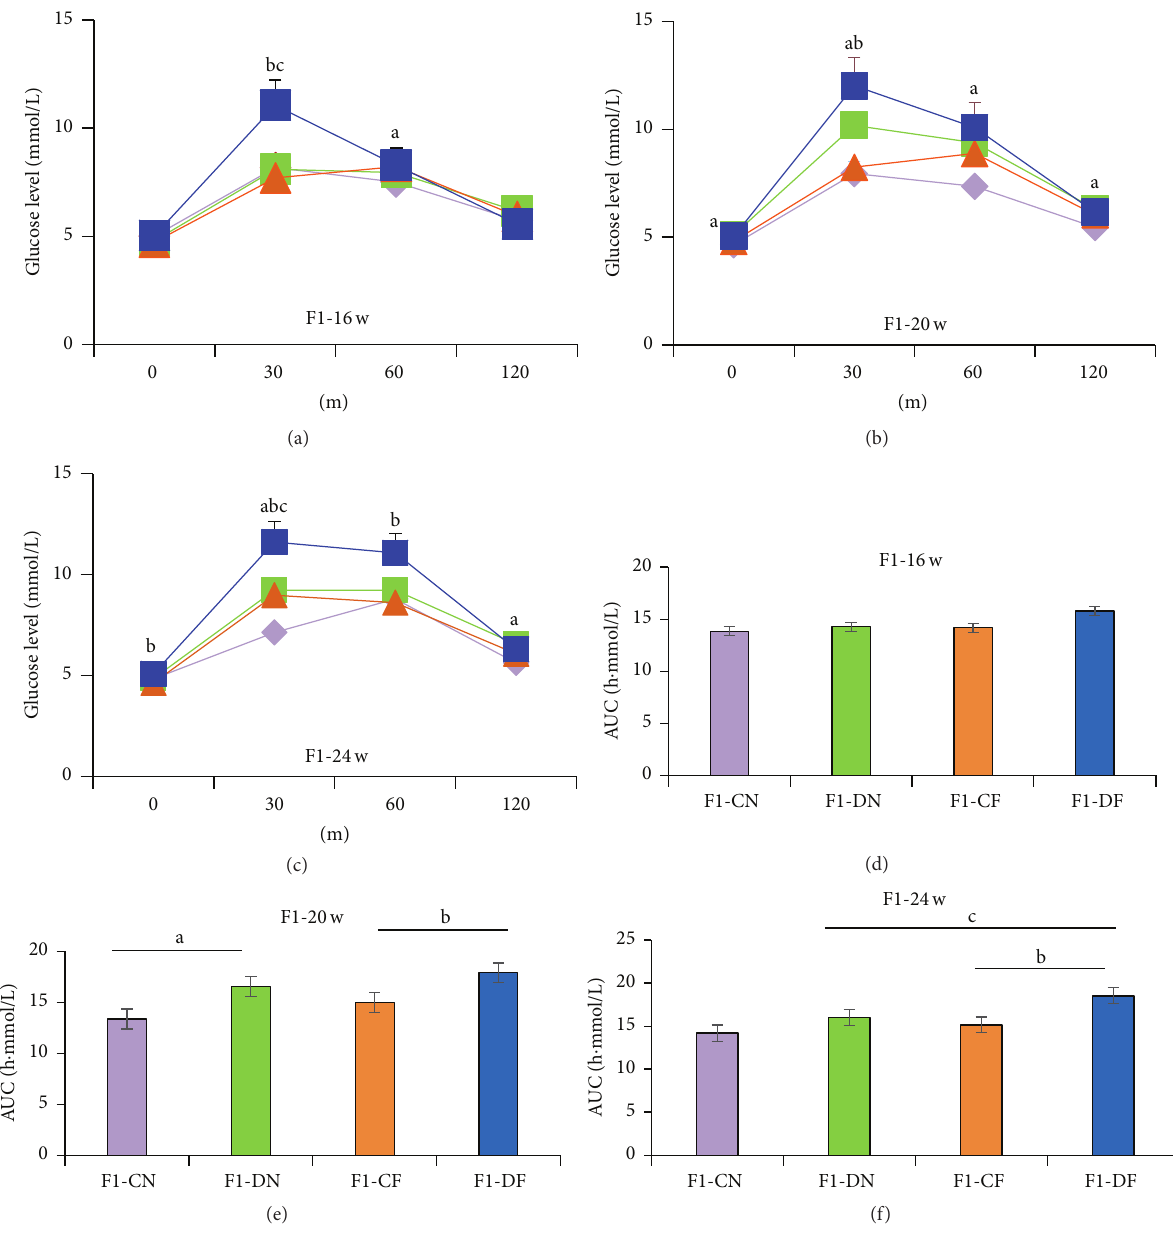
Figure 3: Glucose tolerance test. (a–c) Glucose tolerance test (GTT) was performed at 16, 20, and 24 weeks using 2 g glucose/kg body weight given by gavage. (d–f) AUC was performed at 16, 20, and 24 weeks. The results are presented as means ± SEM, 𝑁 = 8 -9; a 𝑝 < 0.05 versus F1-CN; b 𝑝 < 0.05 versus F1-CF; c 𝑝 < 0.05 versus